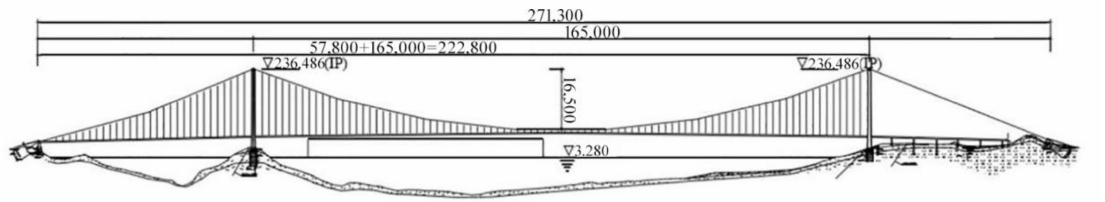
Figure 2. Stereoscopic diagram of Xihoumen Bridge [26].